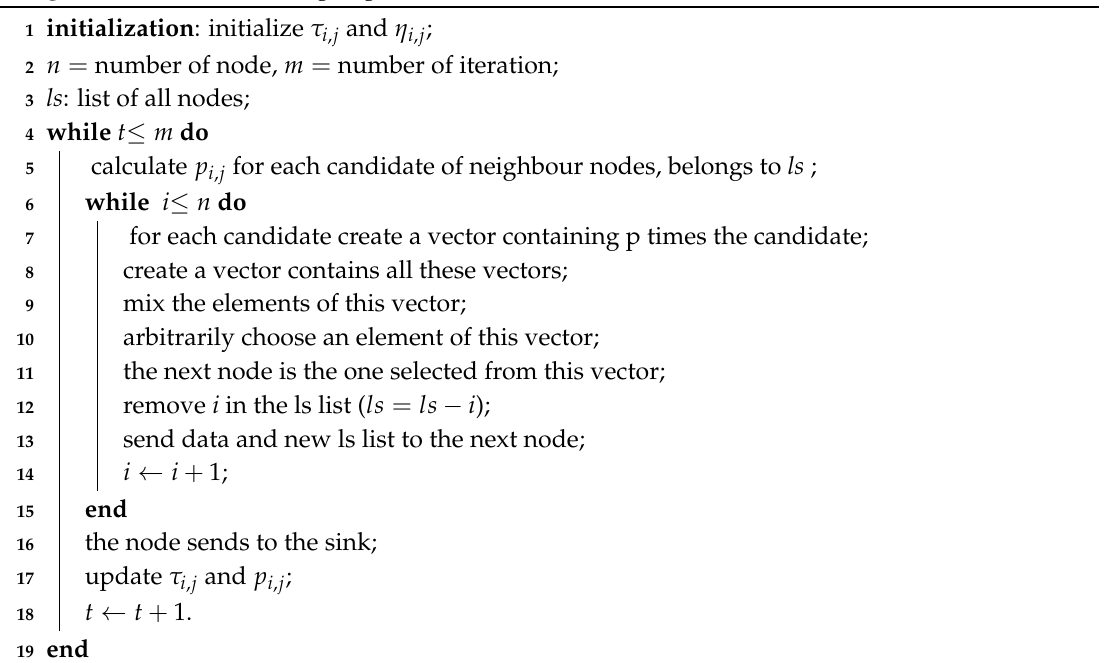
Algorithm 1: Smart Routing Algorithm